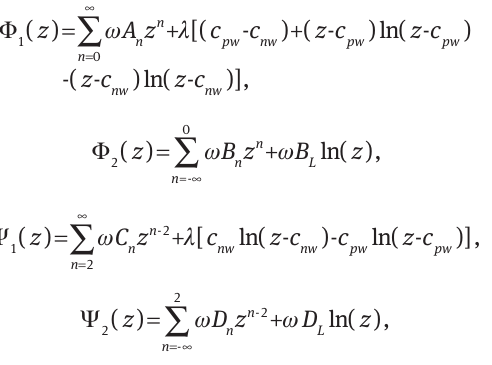
= ν = 0.3, and μ = 0.5 and 2, due to the with a = 2 nm, ν / μ 1 2 2 1 presence of a wedge disclination dipole located on the = 0.5 nm and c = 1.75 nm. The plots are x -axis with c pw nw given for different values of the interface modulus and residual stress. Hereinafter, the superscripts (1) and (2) over the stress components imply that the corresponding stress acts in the nanowire and the matrix, respectively.